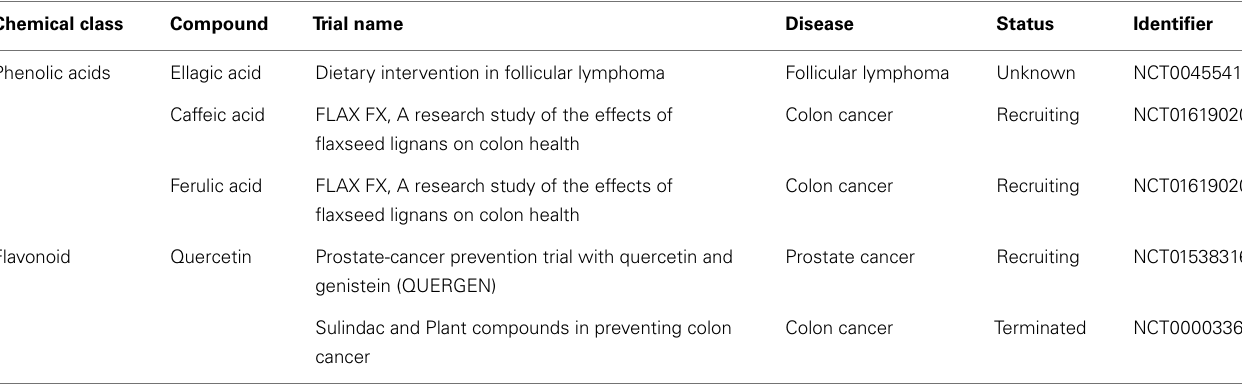
The table was generated by using data available from the website http://clinicaltrials.gov